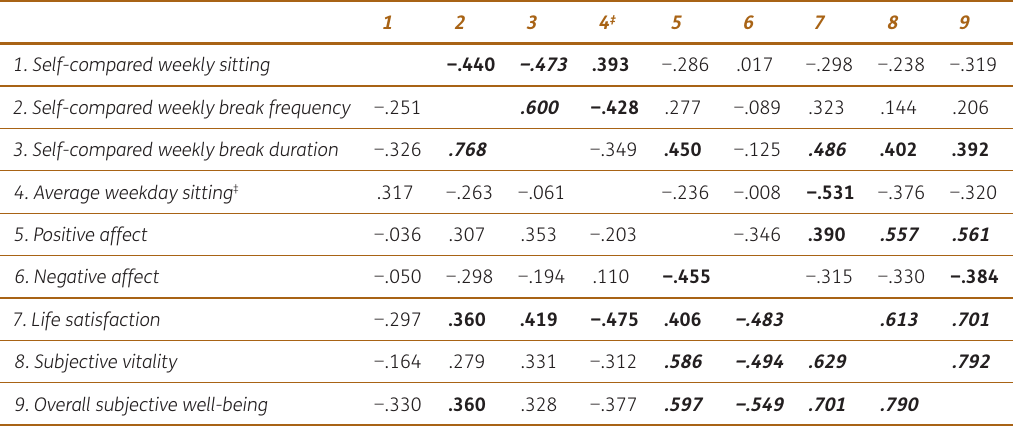
Table 7 Pearson correlation matrix between residuals and absolute differences of self-compared and average weekday SB and outcomes of SWB. ( n =